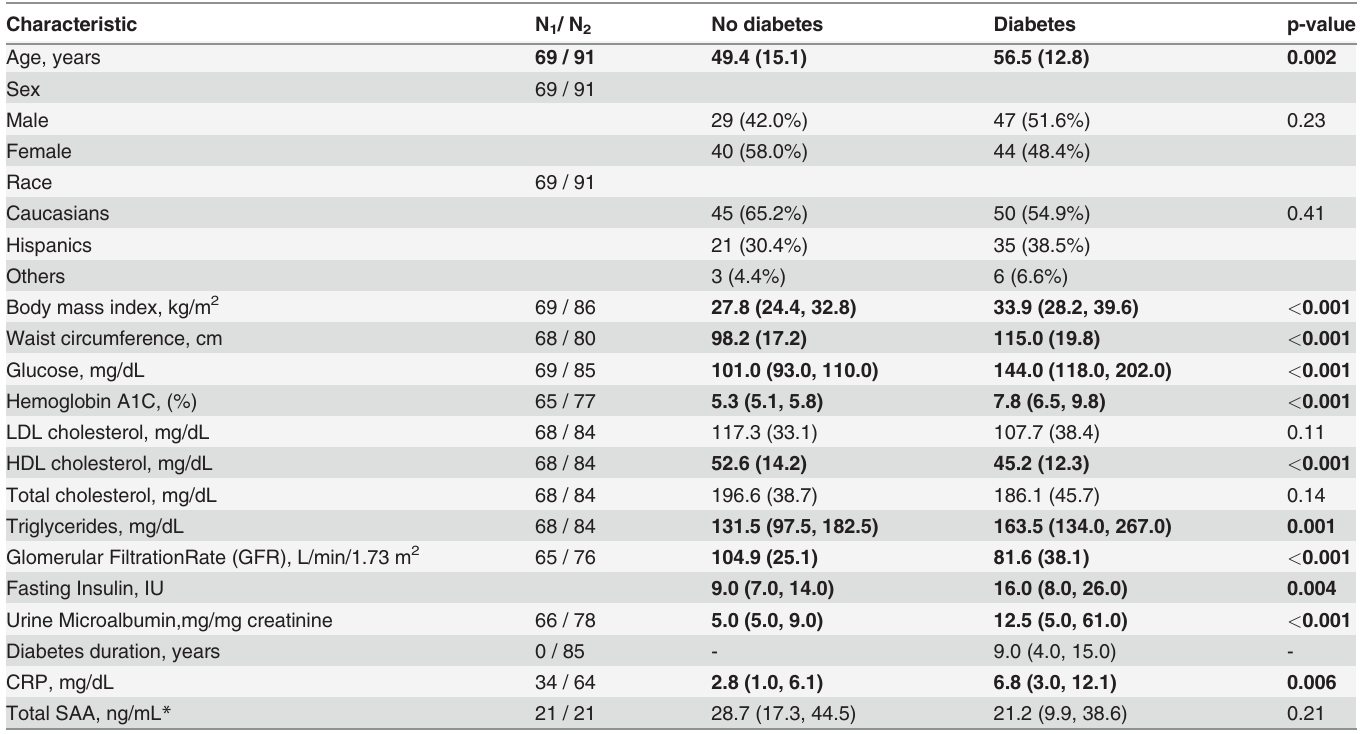
Table 1. Demographic and clinical